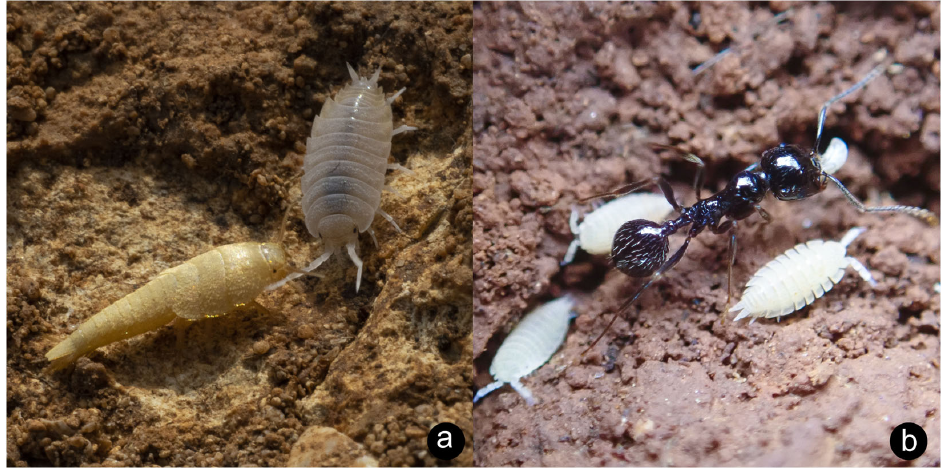
Figure 5. Myrmecophilous isopods and silverfish in Malta; ( a ) Neoasterolepisma crassipes ( left ) and Porcellionides myrmecophilus ( right ) in Messor nest, Rdum tal-Madonna; ( b ) Platyarthrus in Messor nest with worker carrying larva,